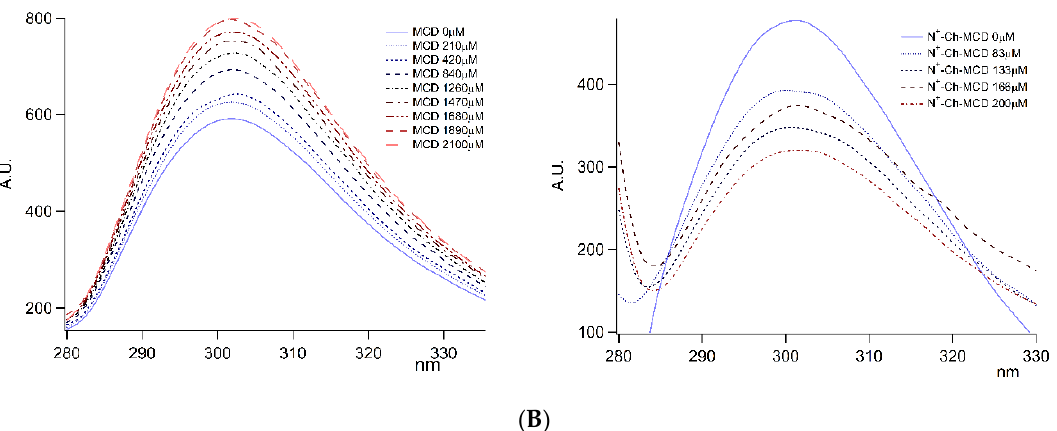
Figure 3. Complex titration by UV and fluorescence spectrometry. ( A ) Overlay of UV second derivative spectra; ( B ) Overlay of emission spectra collected by excitation at λ 275 nm.